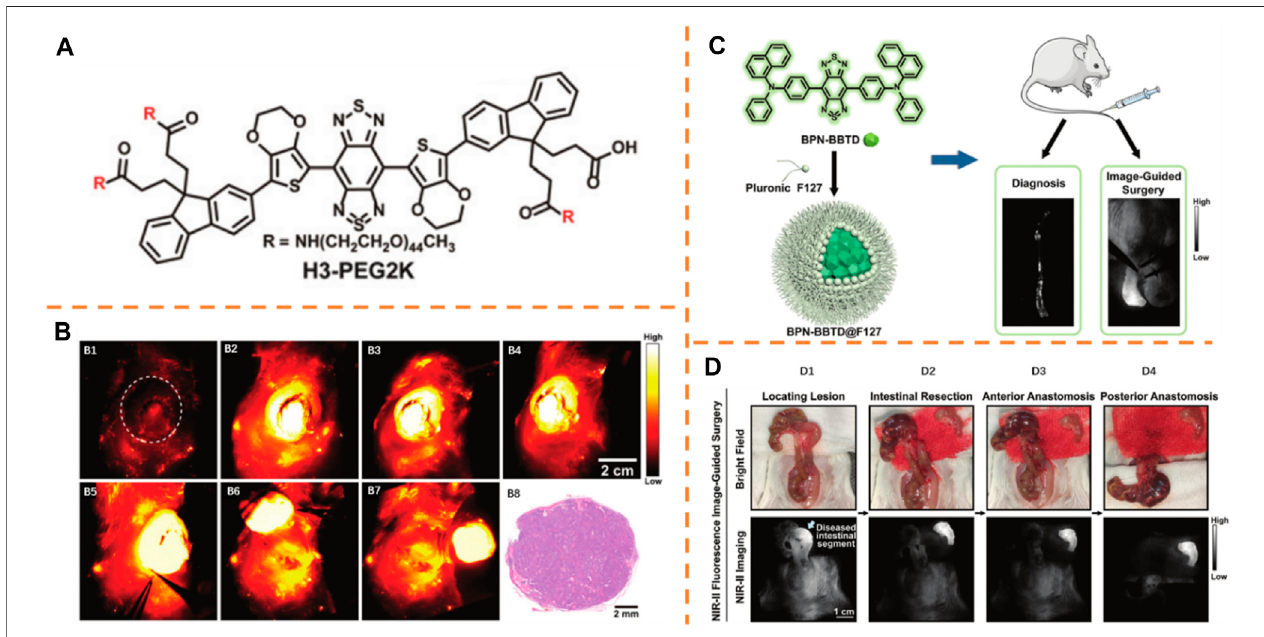
FIGURE 6 | (A) Chemical structure of NIR-II probe H3-PEG2k. Adapted with consent from Zeng et al. (2019). (B) (B1 – B4) : The representative NIR-II fl uorescence images. (B5 – B7) : NIR-II image-guided surgeries after intravenously injecting the probe. (B8) : Hematoxylin and eosin (H&E) staining of the carcinoma resected. (C) Elementary diagram of the preparation step and usage scenes of BPN-BBTD@F127 NPs. Adapted with consent fromFan et al. (2021b). (D) NIR-II fl uorescence image- guided resection of bowel parts with serious in fl ammation.